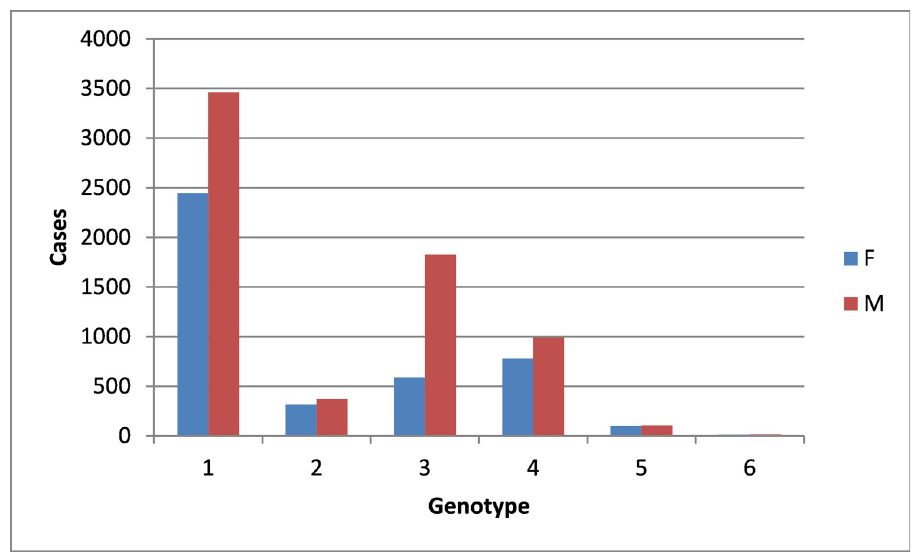
Fig 3. Frequency of the genotypes in function by the gender. Due to the low prevalence, the age distribution for genotype 7 cases was not shown.